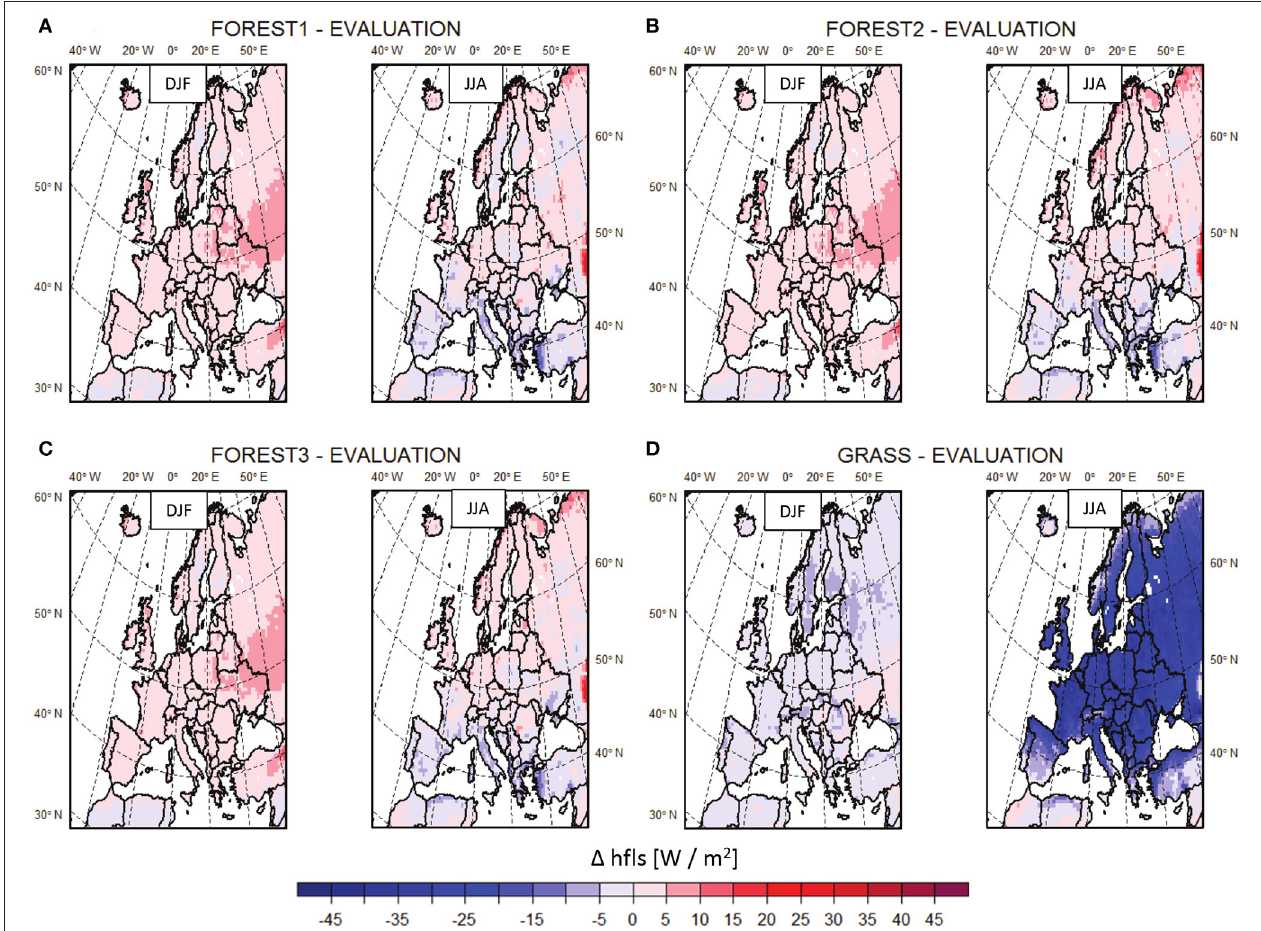
FIGURE 6 | Spatial distribution of mean latent heat flux changes over the EURO-CORDEX domain for the conversion to forest with three different albedo parameterizations [FOREST1 (A) , FOREST2 (B) , FOREST3 (C) ], and to grassland [GRASS (D) ] for winter (DJF, left) and summer (JJA, right) for 1986–2015. The difference between experiments and the EVALUATION simulation with no land cover change is displayed over land points